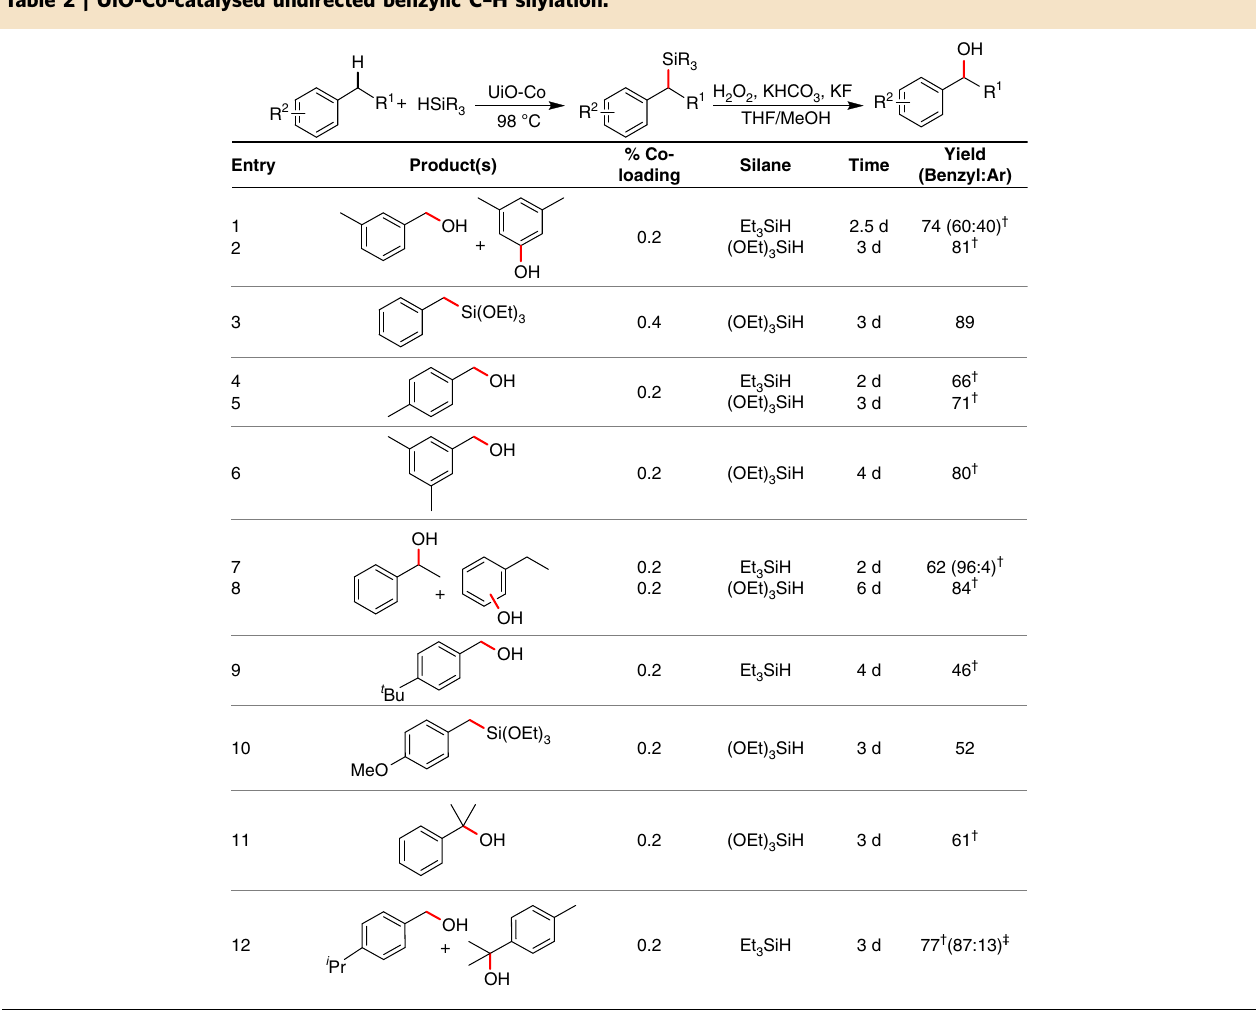
Table 2 | UiO-Co-catalysed undirected benzylic C–H